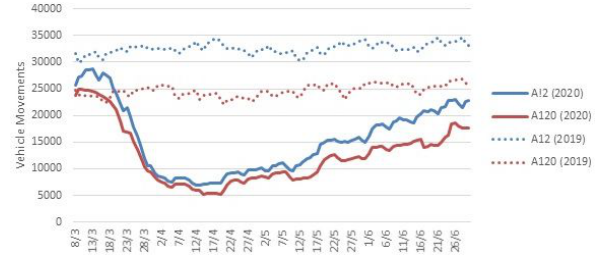
Figure 13: The 7-day rolling average of local daily vehicle move- ments over the Lockdown period and the same period the previous year for the two case studies [20]